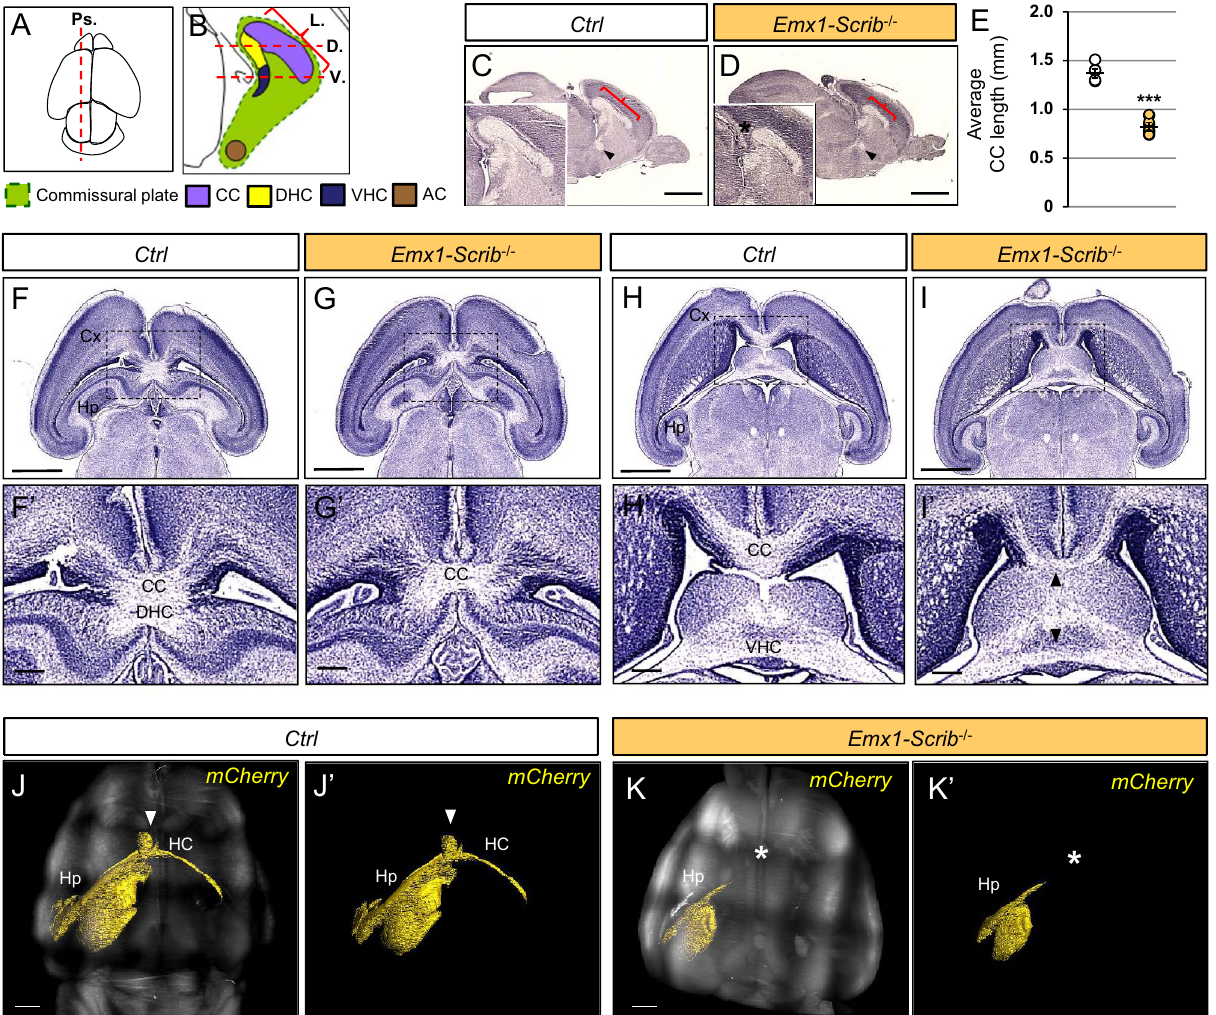
Figure 6. ACC is accompanied by hippocampal commissure agenesis in Scrib −/− cKO mutants. ( A , B ) Schematic dorsal ( A ) or para-sagittal ( B ) views of a P0 mouse brain. Brains were sectioned either para-sagitally (Ps. in A ) or horizontally (in B ) as indicated by the red dashed line at the level of the Dorsal (DHC) or Ventral (VHC) Hippocampal Commissures. CC length (L.) was determined as indicated by the red bracket. ( C , D ) Marked reduction of CC length (see red brackets and asterisk) along the rostrocaudal axis in the brains of Emx1-Scrib −/− ( D , orange, n = 5) cKO brains as compared with those of their control littermates ( C , white, n = 5). The Anterior Commisure (AC) is present in the mutant (black arrowhead). ( E ) Quantification of average CC length (in mm). Statistical analysis via a two-tailed t test ( ***P < 0.0001) using between 3 and 5 brains per genotype from at least 3 independent experiments. ( F–I ) Representative hematoxylin staining of serial horizontal sections from newborn Emx1-Scrib −/− ( G , I ) cKO brains and their respective controls ( F , H ) at the dorsal ( F – G ) and ventral level ( H – I ) as defined in ( B ). ( F ′ –I ′ ) Higher magnification for selected insets (boxed areas) from ( F – I ) illustrating agenesis of the DHC ( G ′ ) and CC hypoplasia ( G ′ , I ′ ). Either dorsal ( F ′ – G ′ ) or ventral ( H ′ – I ′ ) sections showed showed some callosal and hippocampal axon bundles still crossing through the midline. ( J , K ) Light- sheet microscopy imaging of Emx1-Scrib −/− cKO adult brains ( K ) and its control ( J ) cleared with uDISCO. 3D reconstruction of the mCherry expressed after viral infection in the CA3 region of the hippocampus cortex is represented in yellow. The HC (indicated by an arrowhead in control) is absent in brains from cKO mutants (asterisk in K ). Scale bars 1 mm in ( C , D ′ , F – K ), 0.2 mm in ( F ′ – I ′ ). See also Supplementary Fig mouse models 37 . Microcephaly observed in mutants with embryonic Scrib deletion is most likely the result of a combination of disrupted neurogenesis and migration processes, as deficits in any of these critical mechanisms can participate in brain malformation 2 . This multifactor effect of Scrib is consistent with its expression profile. It is expressed throughout the cerebral cortex, both in neuronal progenitors and in the radial glia, also supporting a role in migration. In addition, we also observed Scrib enrichment in the VZ and SVZ at the time of neurogenesis that prompted us to analyze the impact of Scrib loss on progenitors. We observed in Emx1 -Scrib −/− mutant mice a decrease in Ki67-positive proliferating cell population (− 12.2% ± 4.9) associated with a reduction of neuronal progenitor populations: Pax6 + cells (− 12.4% ± 6.0), Tbr2 + cells (− 23.3% ± 6.9). We believe that these reductions